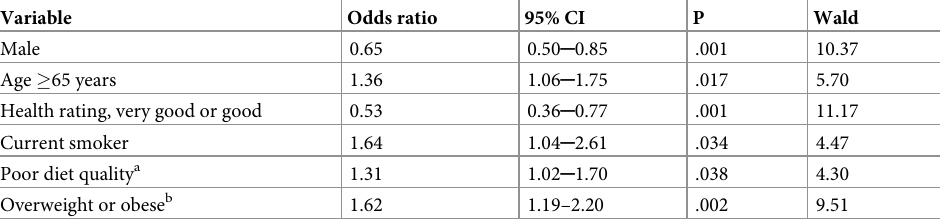
Table 3. Multivariable analysis of factors associated with pre-diabetes according to diagnosis by HbA 1c using ADA classification. Variable Odds ratio 95% CI